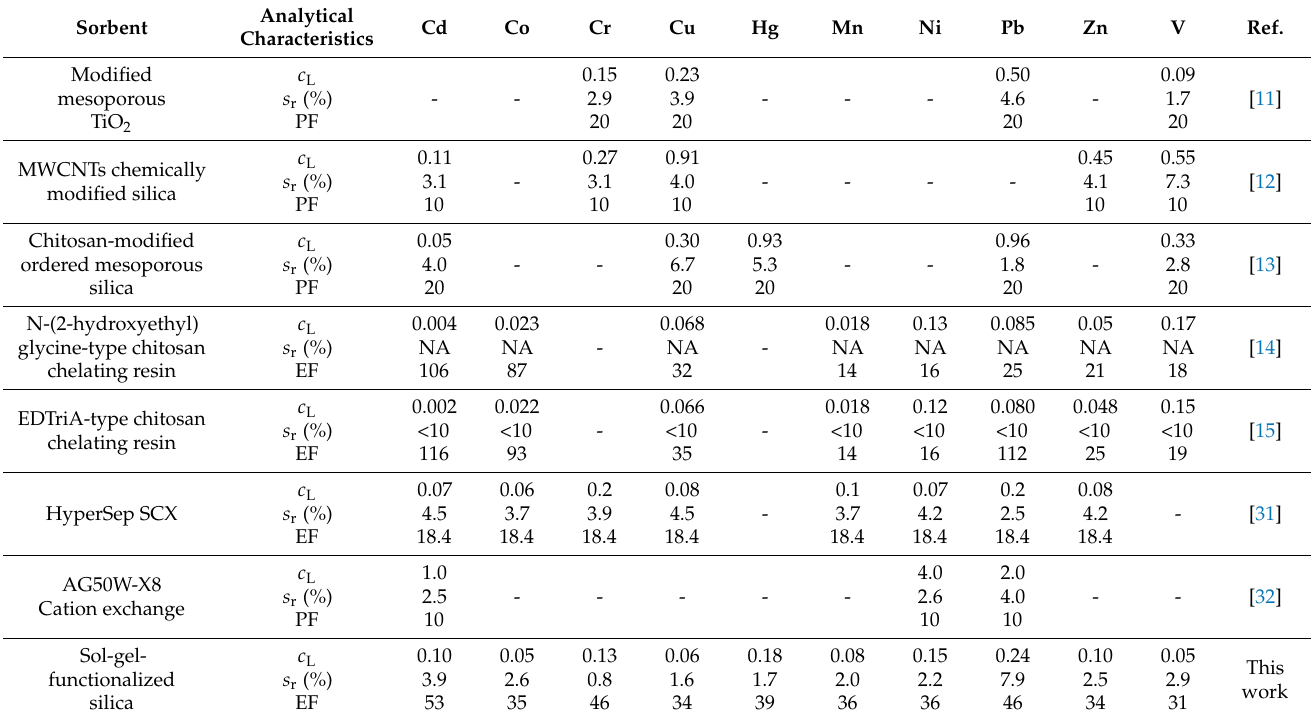
Table 2. Comparison of the performance characteristics of the developed method against selected on-line SPE procedures for multi-element determination with